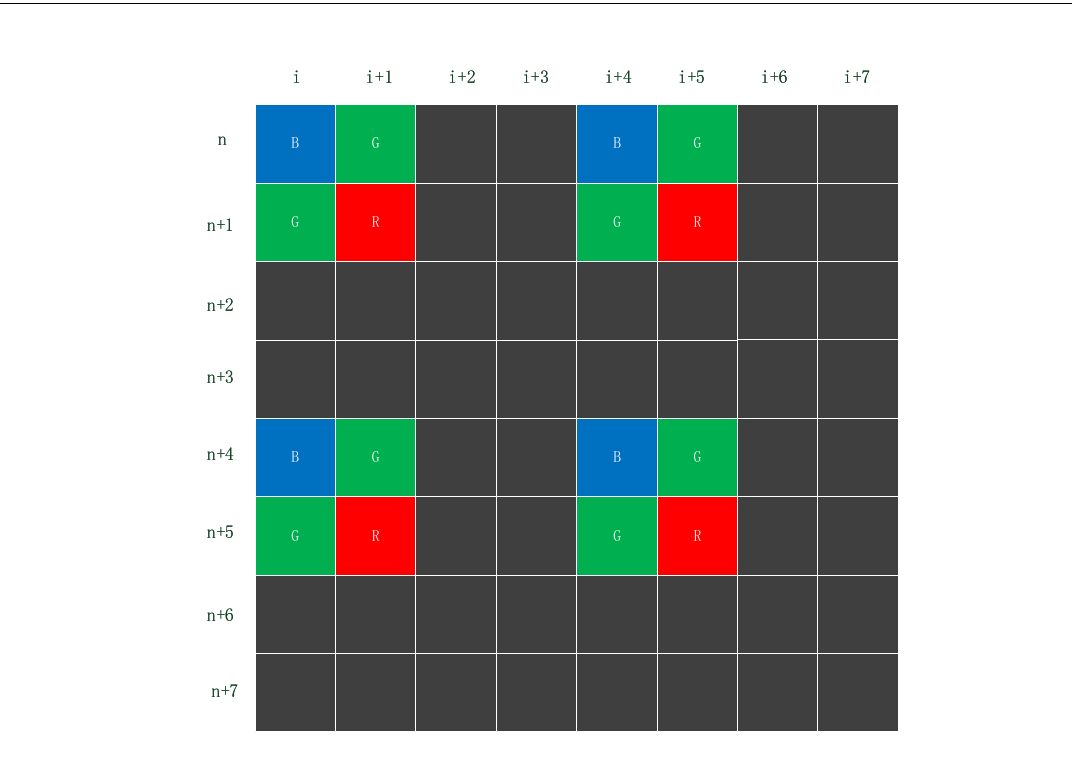
Figure 4. The schematic diagram of 2:2